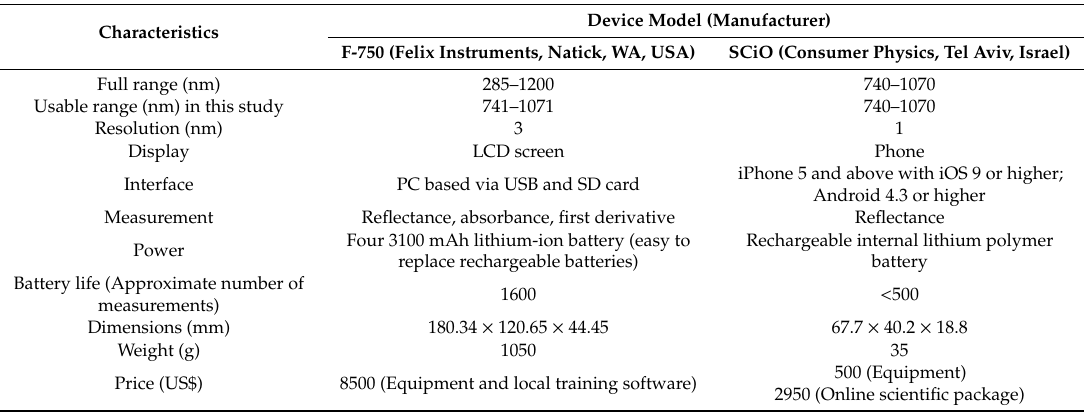
Table 2. Technical specifications of produce quality spectrometers used in the